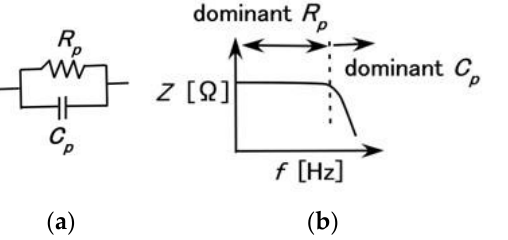
Figure 4. The tendency of impedance based on a parallel electric circuit: ( a ) electric circuit; ( b ) change of impedance based on the parallel electric circuit.